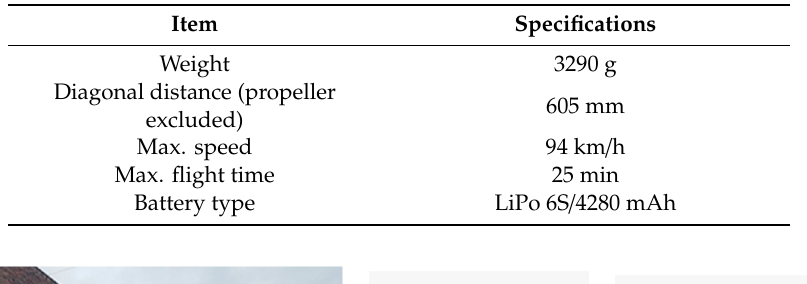
Table 1. Inspire 2 specifications.